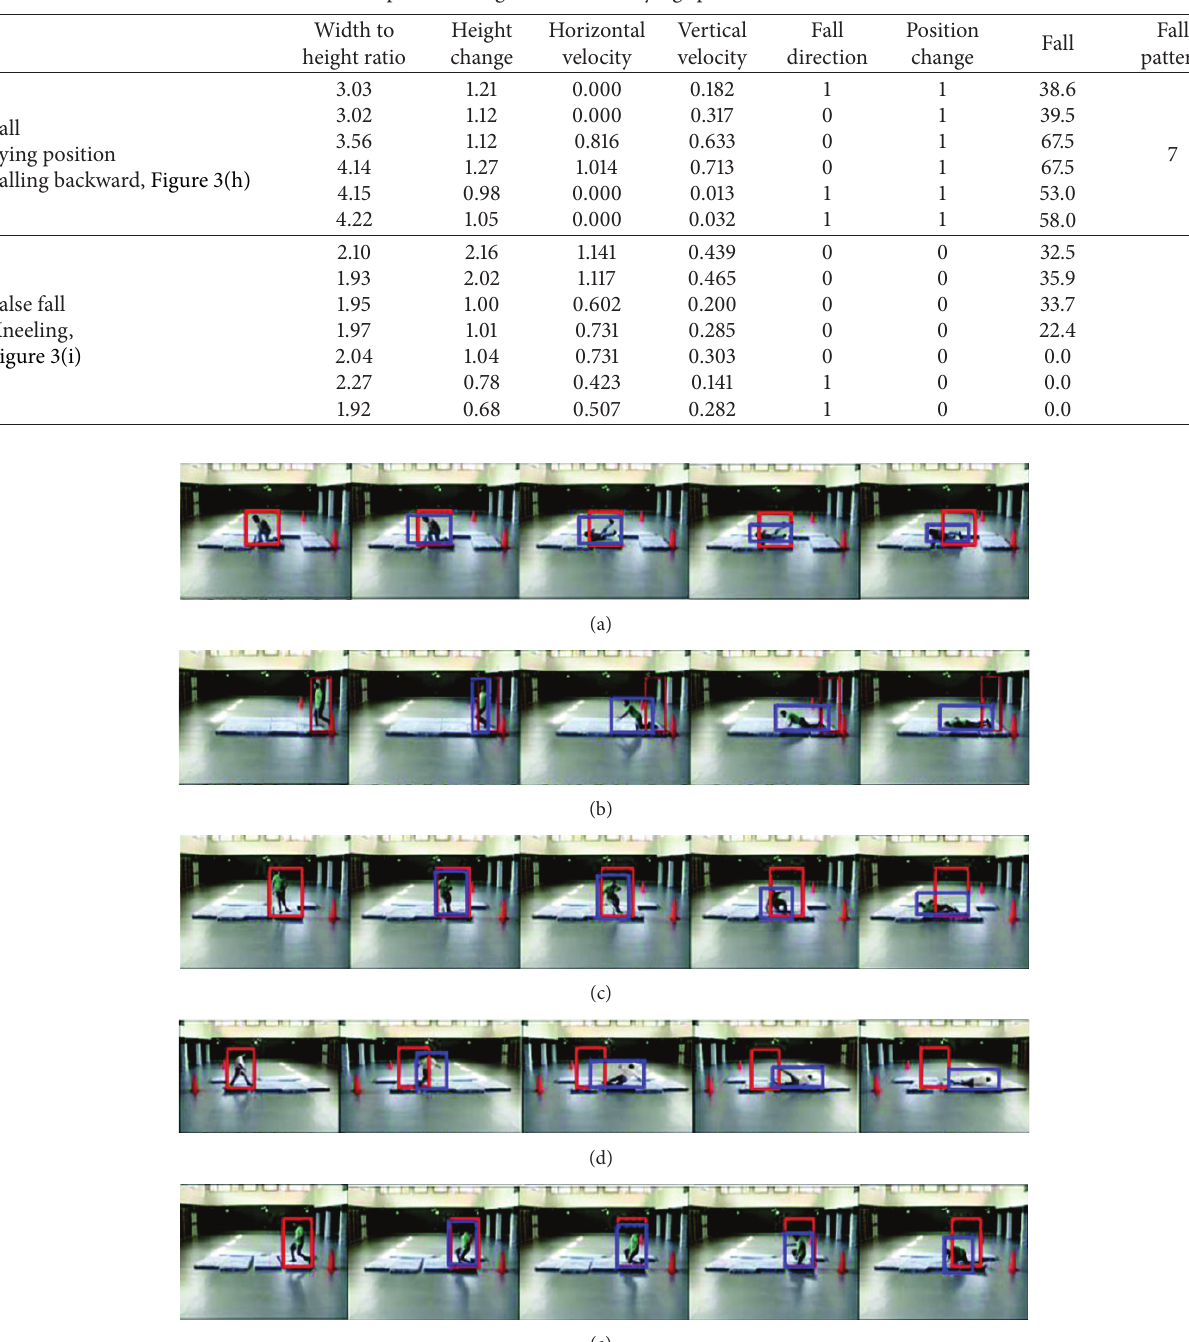
Table 3: Result of fall detection and fall pattern recognition from a “lying” position and results of a false fall detection in infrared.